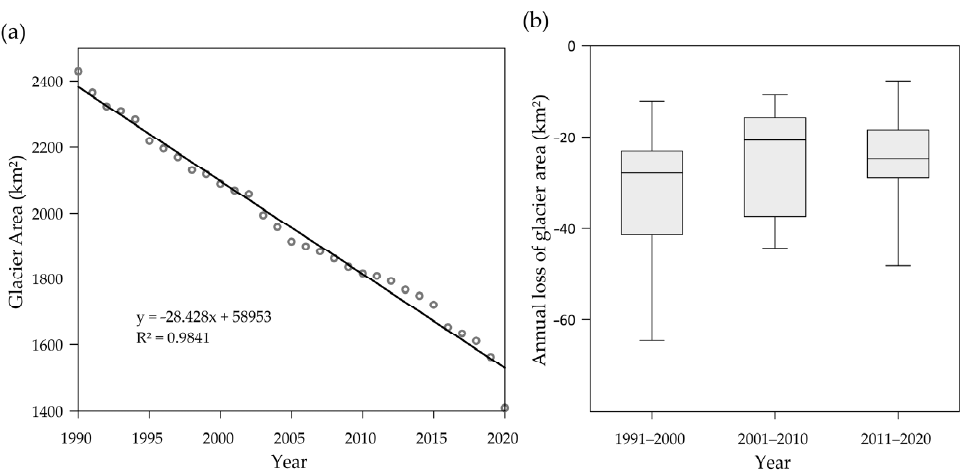
Figure 12. TAGs retreat between 1990 and 2020: ( a ) linear regression of the glacier area throughout the time series, ( b ) boxplot of the glacier area loss by decades.